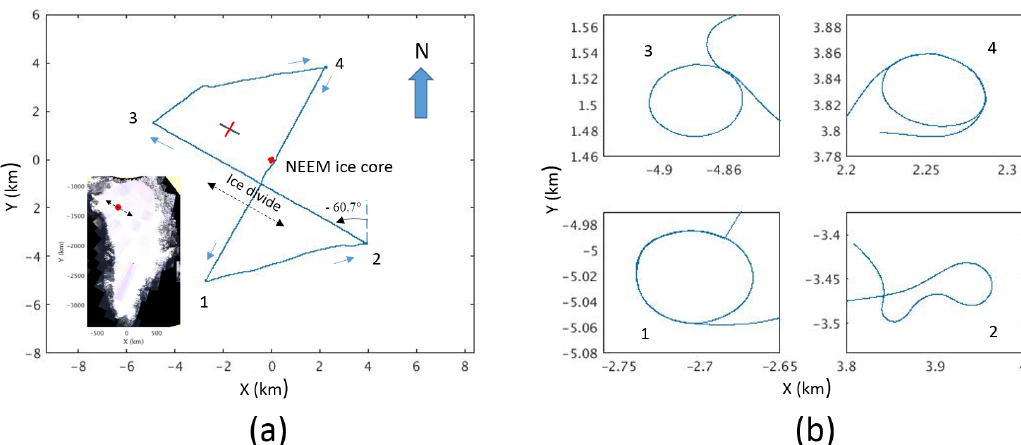
Figure 2. Paths of multi-polarization measurements: (a) paths along ice divide and perpendicular to ice divide. (b) Circular paths at turns. The paths are plotted in the local ENU (east–north–up) coordinate system at the NEEM ice core camp site (77.45 ◦ N, 51.06 ◦ W), marked by a red dot at (0 , 0). The travel direction is illustrated by the arrows along the paths. The local ice divide is along the path from location 2 to 3, as marked by the dashed line with arrows on both ends. The red dot and the dashed line with arrows in the inset map show the location of the NEEM site and the direction of the local ice divide in Greenland. The cross formed by a red and a blue segment shows the location of a crossover where the data were collected with the non-polarimetric HH polarization antenna configuration (see discussions on Fig.